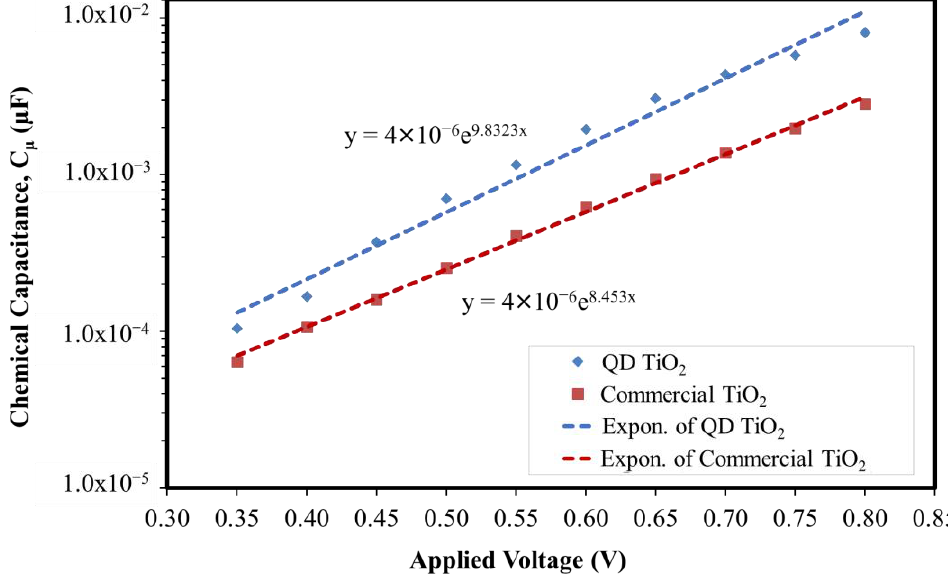
Figure 9. The chemical capacitance of the QD TiO 2 and commercial TiO 2 nanoparticle-based DSCs obtained from the EIS analyses in the dark.